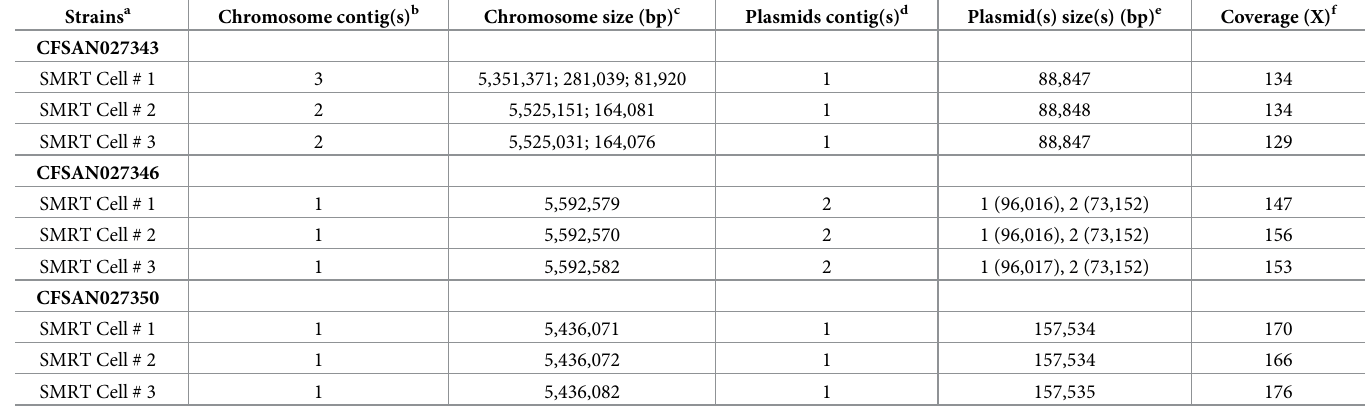
Table 6. Assembly statistics per SMRT cell# for PacBio data using HGAP3.0 and Quiver. Strains a Chromosome contig(s)